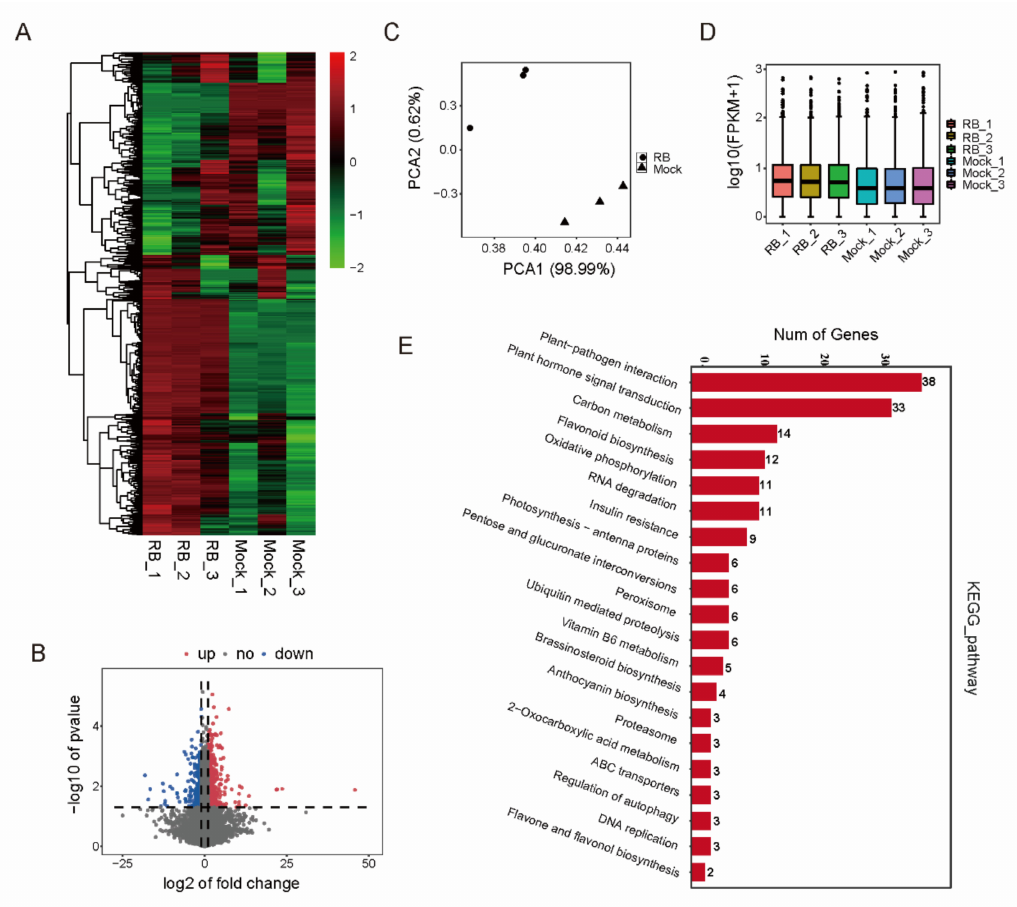
Figure 3. Analysis of RBSDV-infected rice transcriptome. ( A ) Heatmap representation of a one-dimensional hierarchical clustering of di ff erential gene expression as determined by mRNA-seq for the RBSDV-infected rice relative to the control (RBSDV-free). ( B ) Di ff erential transcript abundance of RBSDV-infected and RBSDV-free rice. The y-axis represents the p -value relative to the change in the mean normalized expression of all transcripts (x-axis). Red dots indicate the up-regulated genes, blue dots indicate the down-regulated genes ( p < 0.01). ( C ) Results of principal component analysis. DEGs of RBSDV-infected rice had visible di ff erences. ( D ) Box-whisker Plot FPKM (fragments per kilobase of exon per million fragments mapped) of DEGs (three biological replicates of RBSDV-infected and RBSDV-free rice, respectively). ( E ) KEGG enrichment analysis of RBSDV-infected and control rice transcripts. Y-axis represents pathways, while x-axis represents gene number ( p <